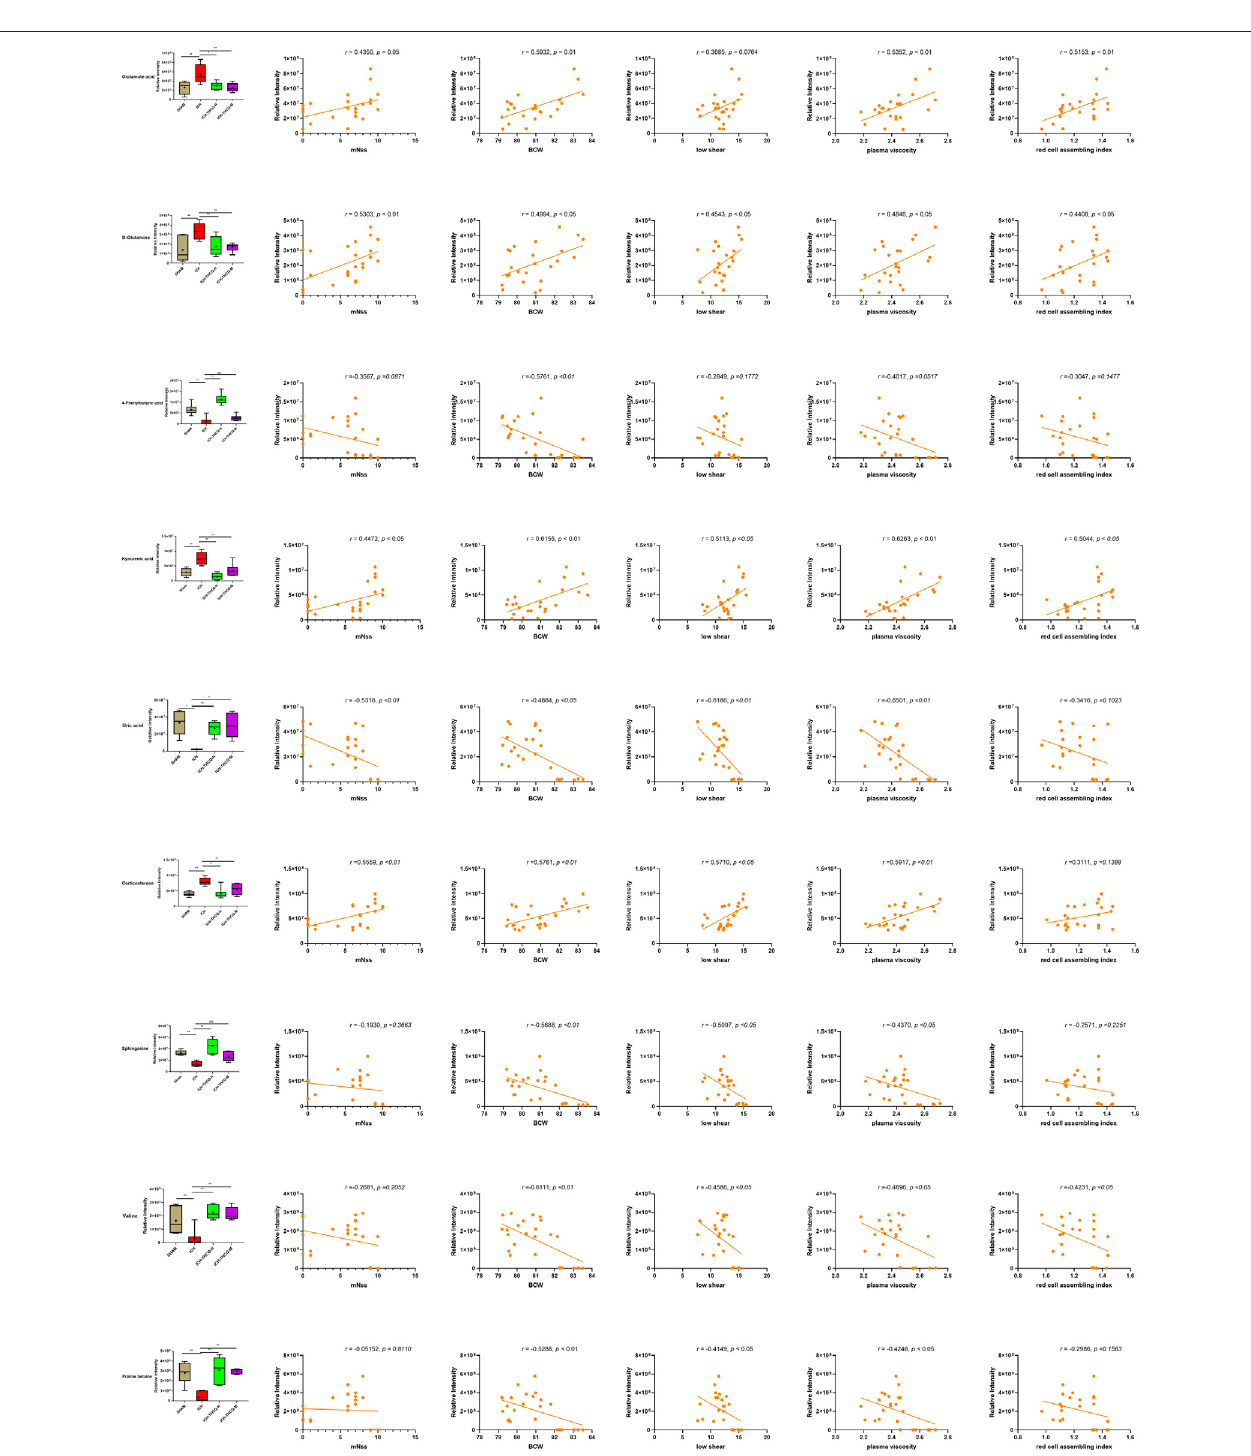
FIGURE9| SSerum biomarkerlevels betweendifferentgroups (A) and their correlationswithICH ef fi cacyindicators (B , mNSS ; C ,BWC; D ,LS; E ,PA; F ,RCAB ) , * p < 0.05 and ** p < 0.01. The distribution and comparison of serum biomarker levels between different groups (A) and their correlations with ICH ef fi cacy indicators (B , mNSS ; C ,BWC; D ,LS; E ,PA; F ,RCAB ) ,* p < 0.05and** p < 0.01. (B) Onemetabolitewassigni fi cantlynegativelyandfourpositivelycorrelatedwith mNSS ( p < 0.05) (C) Fivemetabolitesweresigni fi cantlynegativelyandfourpositivelycorrelatedwithBrainwatercontent( p < 0.05). (D) Fourmetabolitesweresigni fi cantlynegativelyand three positively correlated with Plasma viscosity ( p < 0.05). (E) Four metabolites were signi fi cantly negatively and four positively correlated with whole blood aggregation ( p < 0.05). (F) One metabolite was signi fi cantly negatively and three positively correlated with whole blood aggregation ( p < 0.05).